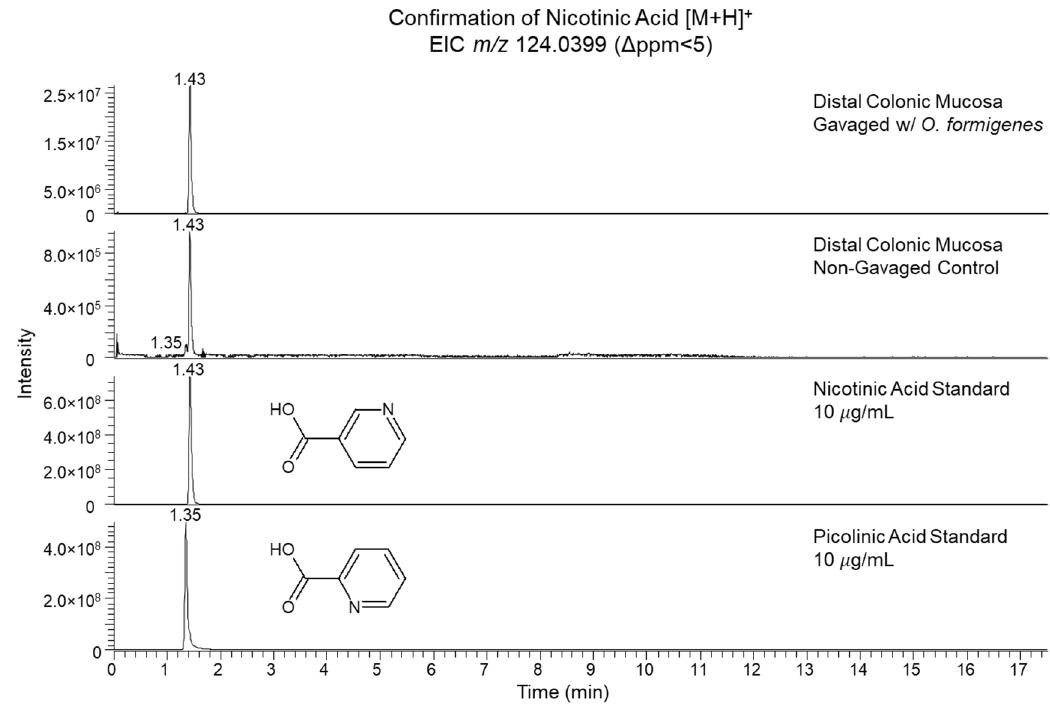
Figure 2. Nicotinic acid is confirmed in the distal colonic mucosa by analysis of pure standards by ultra-high-performance liquid chromatography–high-resolution mass spectrometry (UHPLC–HRMS). Extracted ion chromatogram for m / z 124.0399 ( ∆ ppm < 5) confirms identification of nicotinic acid by chromatographic alignment of O. formigenes -gavaged versus non-gavaged mouse distal colonic mucosal metabolite extracts against pure standards of nicotinic acid and picolinic acid. Peak of interest at 1.43 min in the distal colonic mucosa is identified as nicotinic acid by exact RT match to its pure standard and is di ff erentiated from picolinic acid (1.35